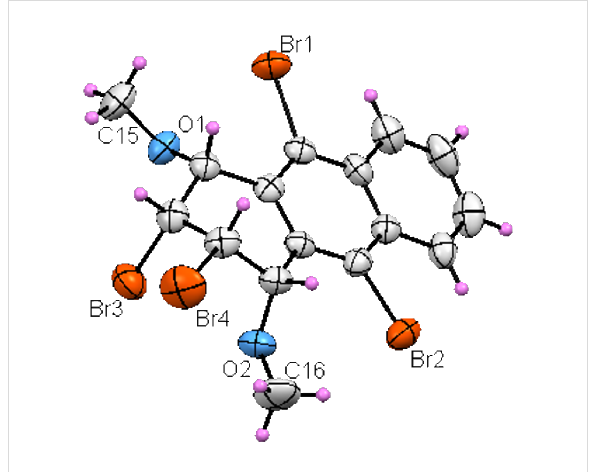
Figure 1: Molecular structure of compound 7 . Displacement ellipsoids are shown at 40% probability level.